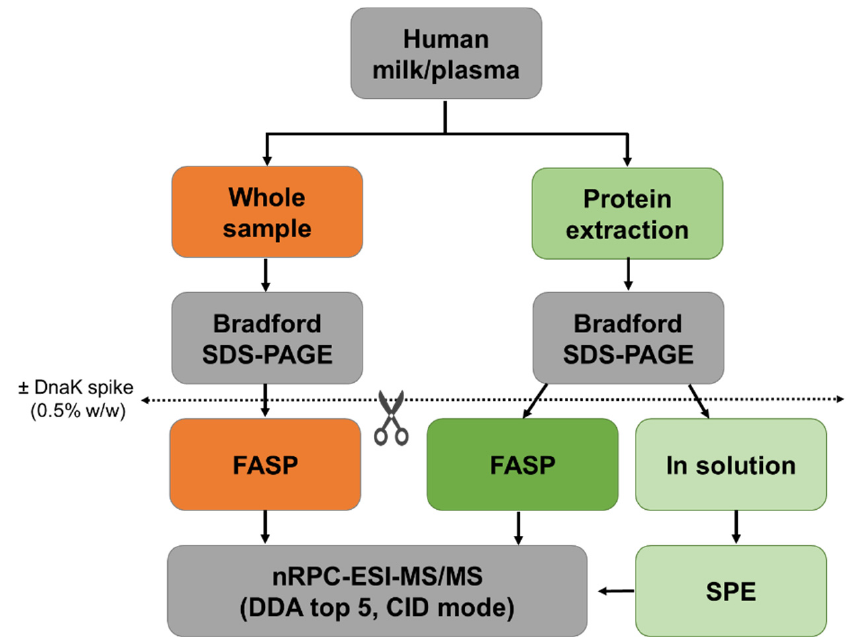
Figure 1. Schematic representation of the workflow. Protein concentrations of human milk and plasma were determined before (orange) and after protein extraction (green). Whole and extracted samples were digested by FASP, and extracted samples were also digested in-solution. Experiments were performed in triplicates with and without the addition of DnaK as an internal control protein. Overall, 264 milk (307 plasma) protein groups were found in samples containing the DnaK spike with ~62% (54.7%) of the proteins being identified by at least two of the applied three methods (Figure 2). The protein coverage was typically below 25%, but in some cases the sequence coverage was higher independent of the applied method (Figure